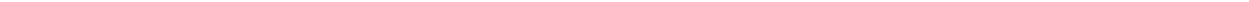
Fig. 6 Browning of iWAT in the transgenic mice improves glucose homeostasis and prevents obesity. a Body temperature of 16-week-old male Hlx transgenic mice ( n = 6) and littermate controls ( n = 5) at 4 °C. b Glucose tolerance test of 15-month-old male Hlx transgenic mice ( n = 5) and littermate controls ( n = 7). c Phosphorylation level of Akt at residue S473 in iWAT. d Body weights of male Hlx transgenic mice ( n = 7) and littermate controls ( n = 9) on a high-fat diet for 12 weeks. e Daily consumption of high-fat diet of male Hlx transgenic ( n = 6) and littermate control mice ( n = 5). White bar , wild type; Blue bar , transgenic mice. f Fat mass of mice in ( d ). White bar , wild type; Blue bar , transgenic mice. g Representative image of iWAT after a 12-week high fat diet. h H&E staining of iWAT and liver after a 12-week highfat diet. Shown are representative images of three mice per genotype. Scale bar , 200 µ m. i Hepatic triglyceride levels of mice in ( d ) after a 12-week highfat diet. White bar , wild type; Blue bar , transgenic mice. j Circulating triglyceride levels of mice in d after a 12-week high-fat diet. White bar , wild type; Blue bar , transgenic mice. k Steady state (5 h fasting) glucose level in a second cohort of male Hlx transgenic ( n = 7) and littermate control mice ( n = 5) after 12-week highfat diet. White bar , wild type; Blue bar , transgenic mice. l Glucose tolerance test of mice in ( d ) after 11-week highfat diet. Mice were fasted for 15 h. m Body weights of 10-week-old ob/ob mice ( n = 9) and ob/ob mice with Hlx transgene ( n = 6). n H&E staining and triglyceride content in liver of 10-week-old ob/ob mice ( n = 6) and ob/ob mice with Hlx transgene ( n = 6). Scale bar , 200 µ m. o Body temperature of 10-week-old ob/ob mice ( n = 5) and ob/ob mice with Hlx transgene ( n = 4) at 4 °C. All error bars represent s.e.m. Two-tailed unpaired Student ’ s t-test was performed. * p < 0.05; ** p < 0.01; *** p <